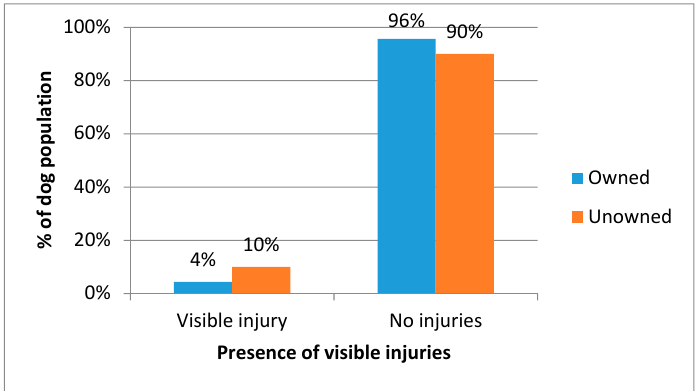
Figure 7. Percentage of owned and unowned dogs observed with and without a visible skin problem.